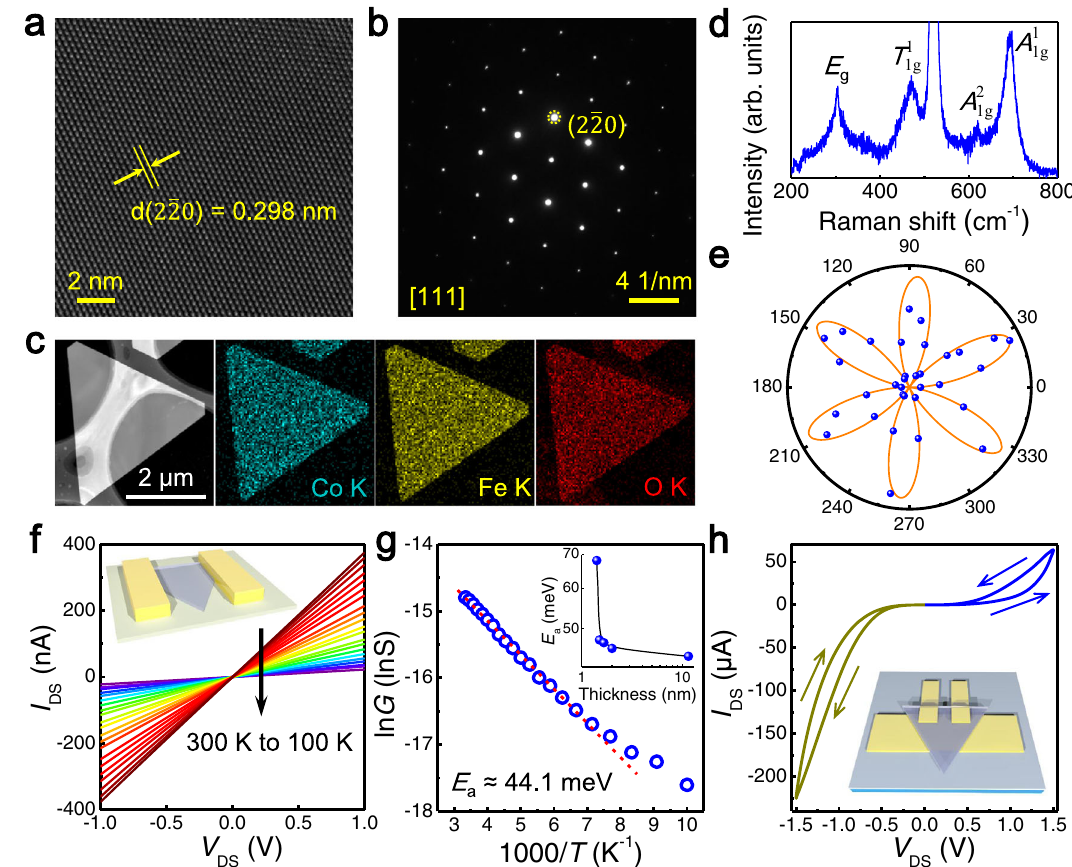
Fig. 2 | Sample characterizations and electrical properties of CFO nanosheets. HRTEMimage( a ),SAEDpattern( b )andTEM-EDSelementalmappingimages( c )of ultrathin CFO nanosheets. Here the lattice spacing is measured to be 0.298nm, correspondingtoits(2 (cid:1) 20)planes. d RamanspectrumofCFOnanosheettransferred onto silicon substrat e . e Polarimetric SHG pattern obtained by rotating the CFO nanosheet while fi xing the polarization of incident laser and collection analyzer. The solid line is the fi tting curve. f I DS – V DS curves of an 11.5 nm-thick CFO device